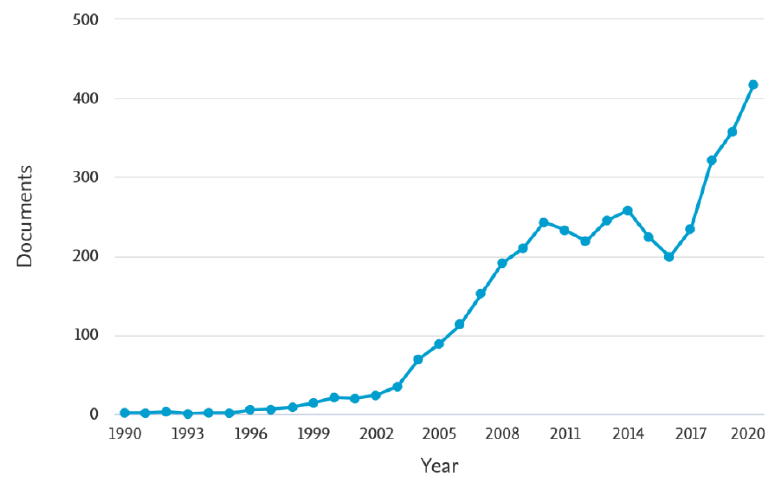
Figure 1. Number of publications on genetic algorithms and logistics.